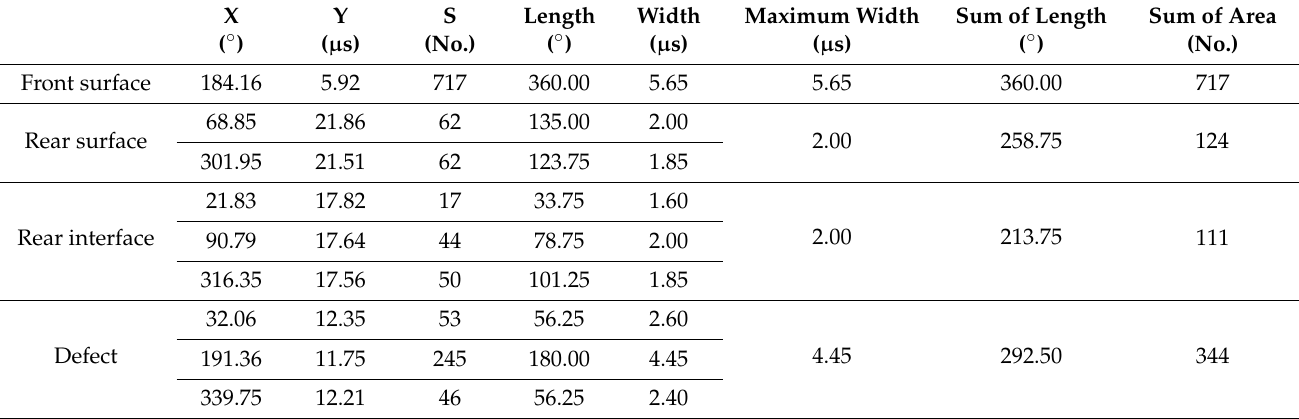
Table 3. Geometric feature information of selected hole defect image.